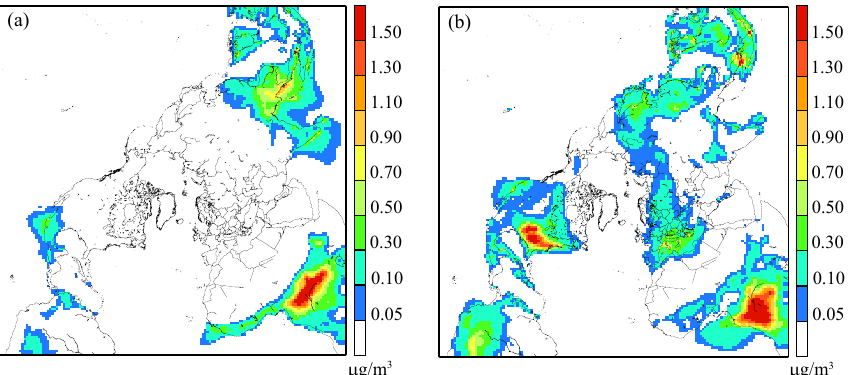
Fig. 4. The surface-layer concentrations (µgm − 3 ) of SOAs in January and July simulated by DEHM based on two-product approach for SOA formation in 2006.